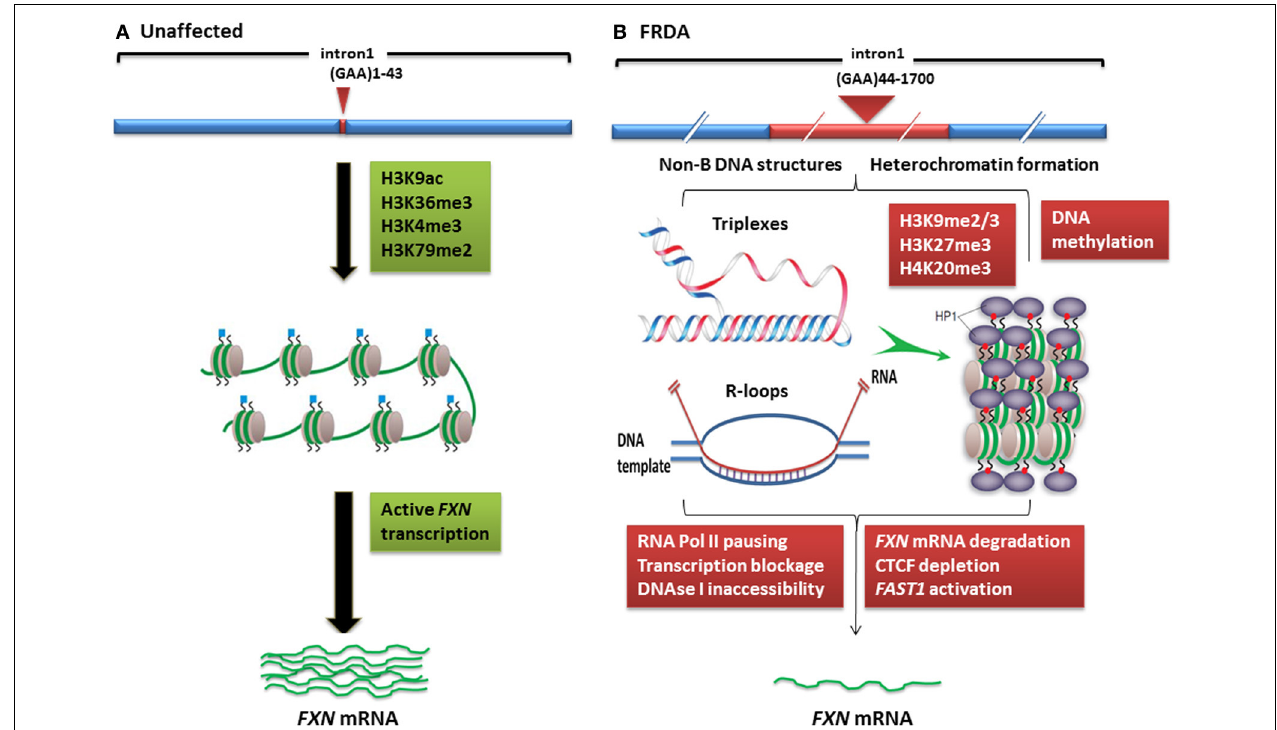
FIGURE 1 | Models of FXN gene silencing in FRDA. (A) Unaffected individuals, who carry up to 43 GAA • TTC repeats, contain active histone marks of gene transcription initiation and elongation at the FXN promoter and intron 1 regions. (B) In FRDA patients, the presence of large GAA • TTC repeat expansion leads to FXN gene silencing by two potential mechanisms: (i) the GAA • TTC repeat may adopt abnormal non-B DNA structures (triplexes) or